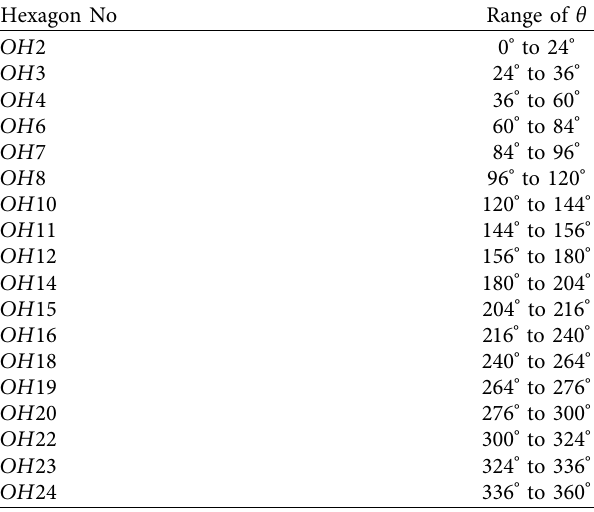
Figure 8: 6L SVD with inscribed circle at 1.0 M . Table 6: Selection of 2L hexagons from 6L SVD.